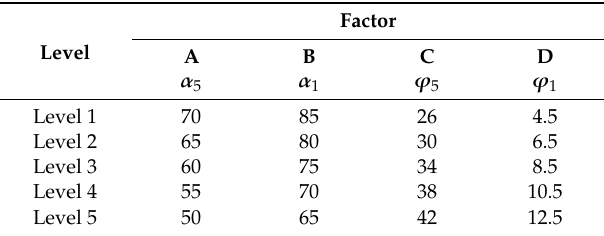
Table 2. Level of the orthogonal factor.